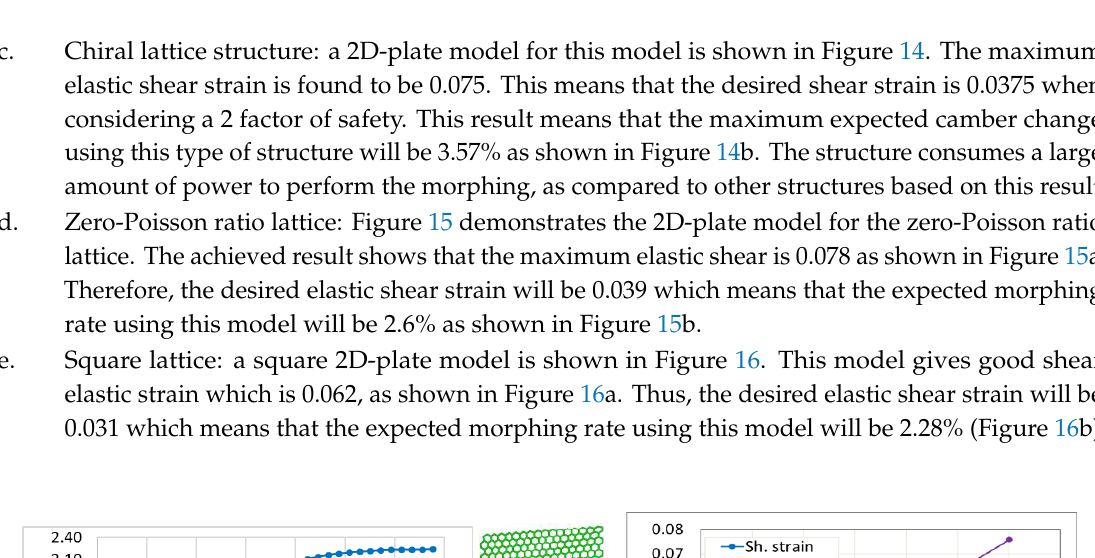
Figure 12. ( a ) In-plane shear stress/strain curve and ( b ) percentage of camber change vs. corresponding strain.